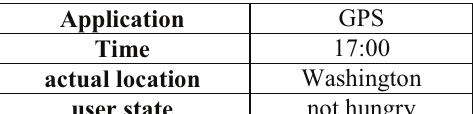
Table 2. The captured information